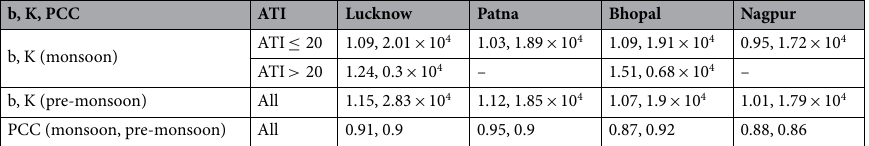
b, K, PCC ATI Lucknow Patna